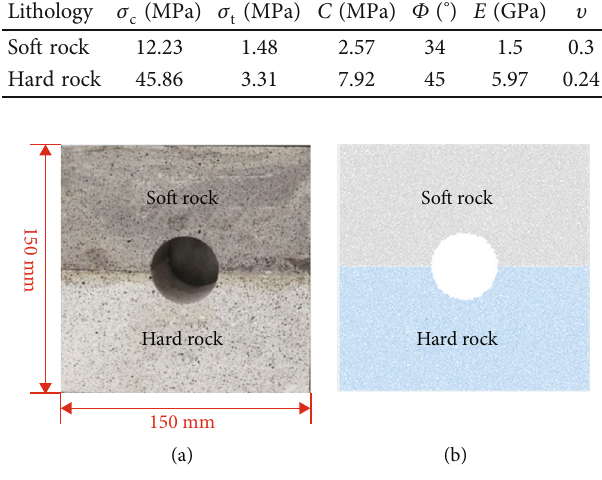
Figure 1: Schematic diagram of laboratory specimens and numerical